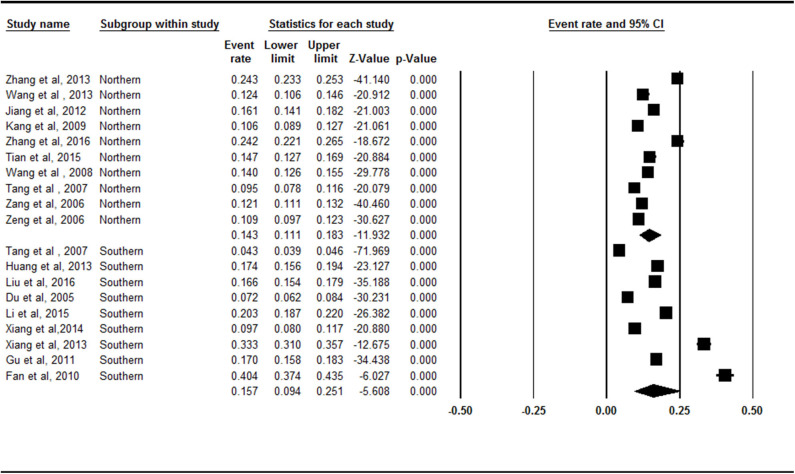
Forest plot of the prevalence rates of symptomatic knee osteoarthritis by area. CI, confidence interval. A total of 19 studies were included in this subgroup meta-analysis. Ten of these studies were conducted in Northern China and 9 studies were conducted in Southern China. The South (15.7%, 95% CI = 9.4–25.1%) had a higher prevalence of symptomatic knee osteoarthritis than the North (14.3%, 95% CI = 11.1–18.3%) in the subgroup analysis.